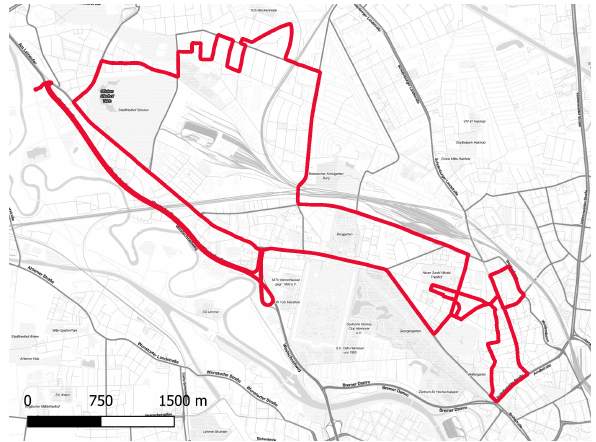
Figure 4. The route of the mapping campaign which provides the data is in the northern part of Hanover, Germany (basemap: Stamen